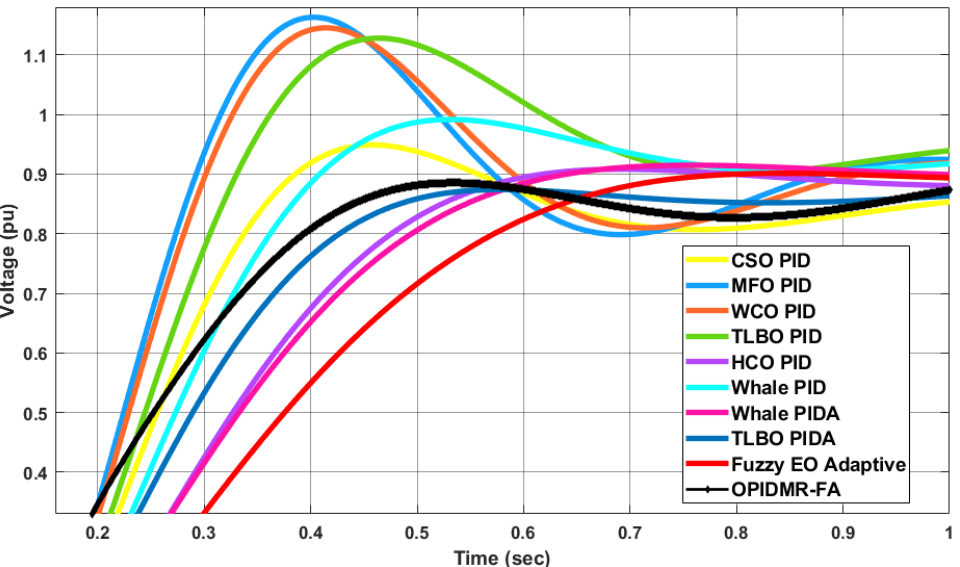
Figure 11. Step-change of 0.9 p.u. on the voltage reference of the AVR model.